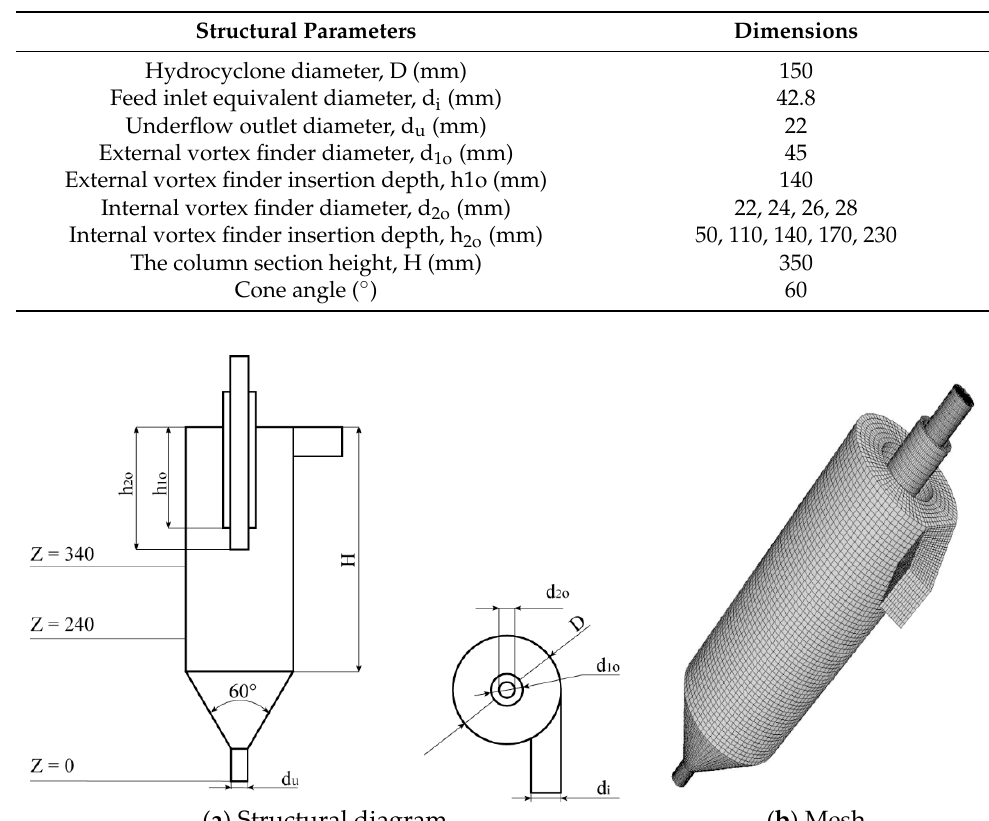
Figure 1. Structural diagram and mesh of a double-overflow three-product